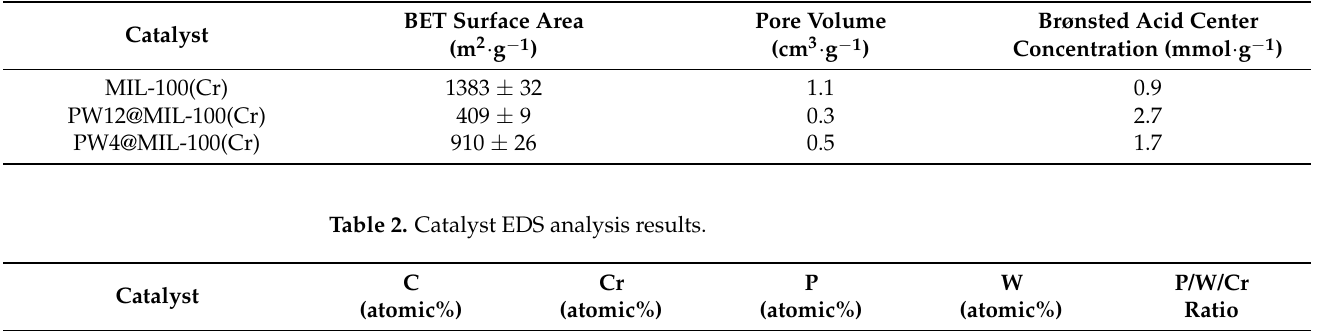
Table 1. Catalyst textural properties.